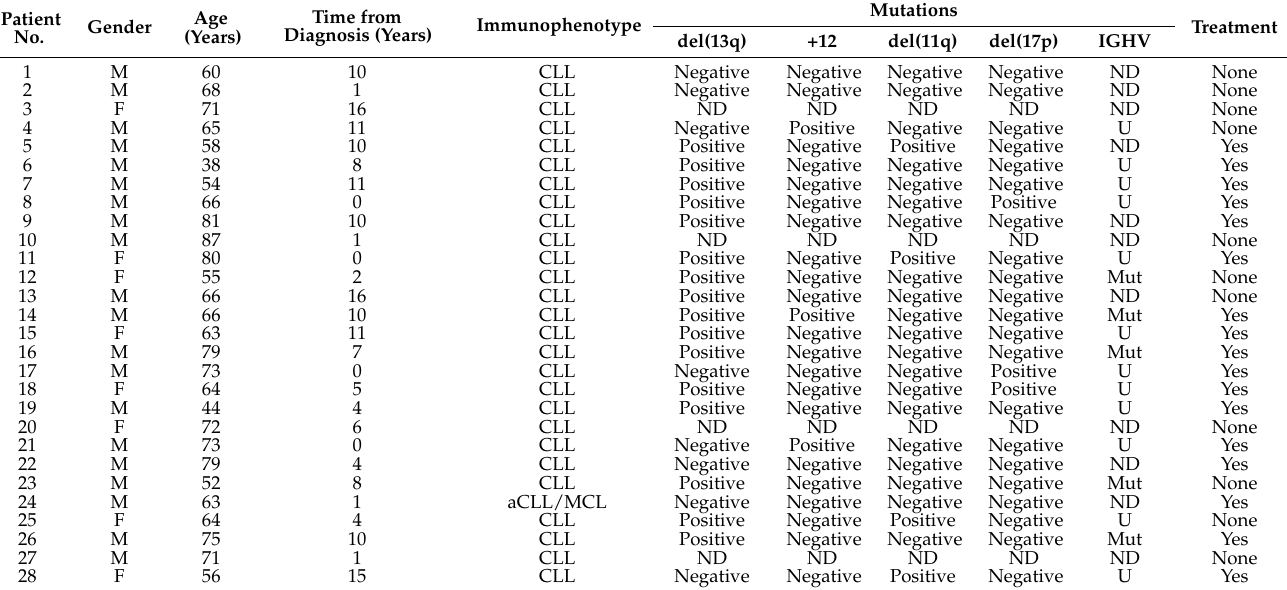
In contrast, when autophagy is inhibited, GFP accumulates, and RFP remains intact. The ratio of RFP to GFP fluorescence thus defines the measure of autophagic flux in cells. Cells (5 × 10 5 cells/mL) were treated with 1 µ M to 25 µ M venetoclax for 24 h. The cells were then pelleted, resuspended in 50 µ L PBS, and analyzed using an imaging flow cytometer (Amnis ImageStream X Mk II; Luminex Corporation, Austin, TX, USA). A minimum of 10,000 events in focus was collected per sample. The median fluorescence intensity (MFI) of RFP and GFP was assessed. Table 1. The clinical characteristics of the patients with CLL included in this